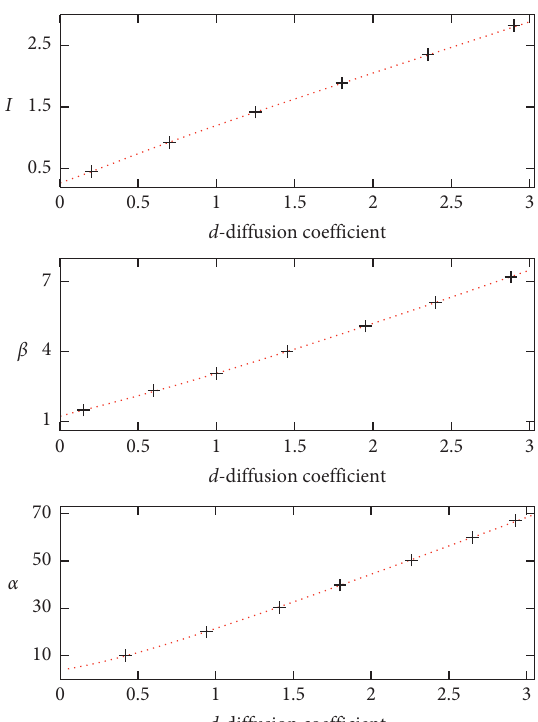
Figure 4: The Hopf bifurcation curves for D − I (upper graph), D − β (middle graph), and D − α (lower graph). In each case, the analytical (red dashed lines) and numerical simulation results (black crosses) are plotted.